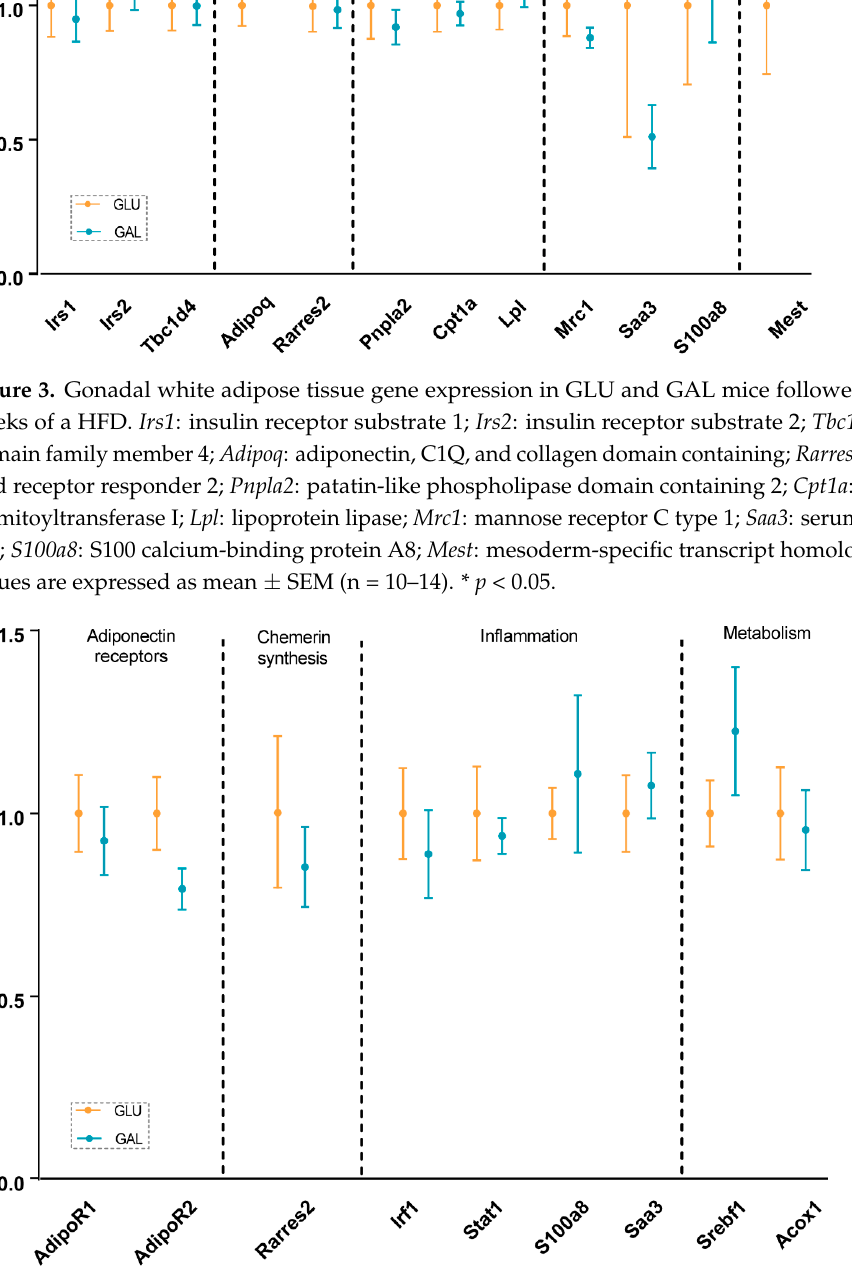
Figure 4. Hepatic gene expression in GLU and GAL mice followed by nine weeks of a HFD. Adi- poR1 : adiponectin receptor 1; AdipoR2 : adiponectin receptor 2; Rarres2 : retinoic acid receptor responder 2; Irf1 : interferon regulatory factor 1; Stat1 : signal transducer and activator of transcription 1; S100a8 : S100 calcium binding protein A8; Saa3 : serum amyloid A 3; Srebf1 : sterol regulatory element binding transcription factor 1; Acox1 : acyl-CoA oxidase 1. Values are expressed as mean ± SEM (n =